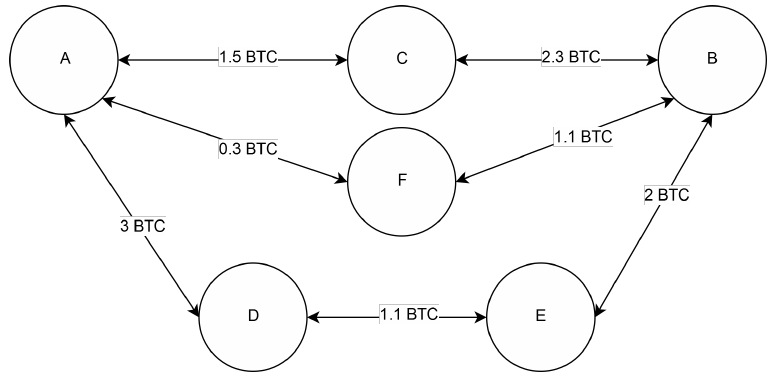
Figure 1. Representation of different options for a multi-hop transaction. Circles represent users’ nodes while the bi-directional channels are represented with arrows in both